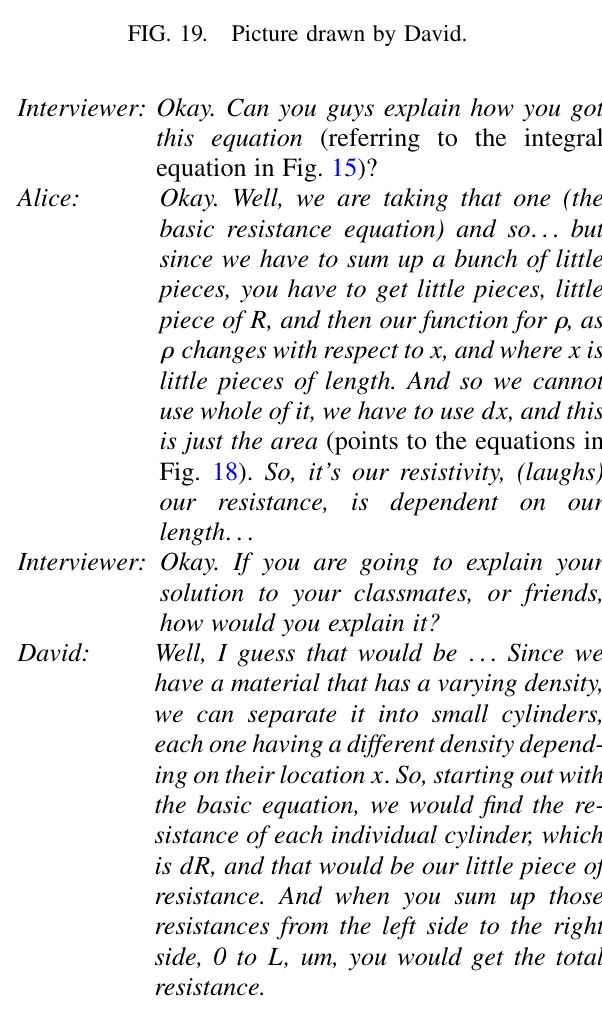
FIG. 17. David’s gesture about ‘‘different values.’’